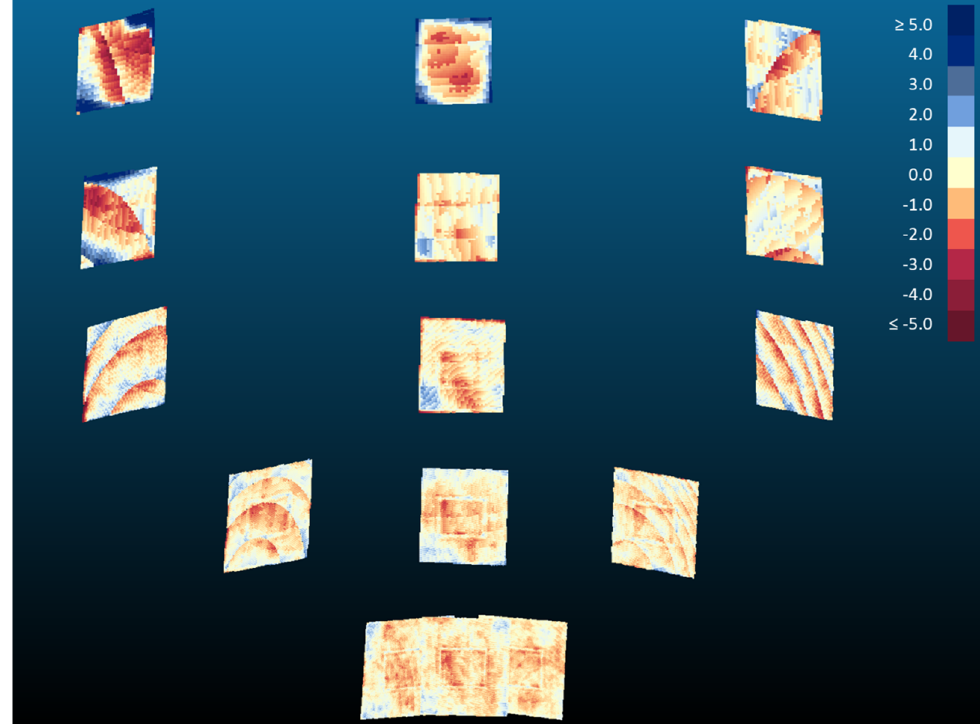
Figure 16. Color map distance plots of the averaged Azure Kinect point clouds to their planes of best fit. Distance values are in millimeters.